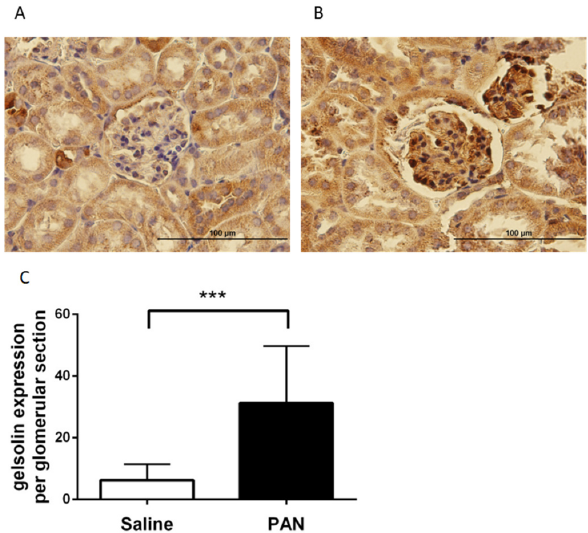
Figure 6. Histological analysis of gelsolin expression in the glomeruli of PAN mice. ( A ) IHC staining of gelsolin expression in kidney sections of control mice. (Magnification: 400×). ( B ) IHC staining of gelsolin expression in kidney sections of PAN mice. (Magnification: 400 × ) (PAN = Puromycin aminonucleoside). ( C ) Quantitative comparison of gelsolin induction after injection. *** p <